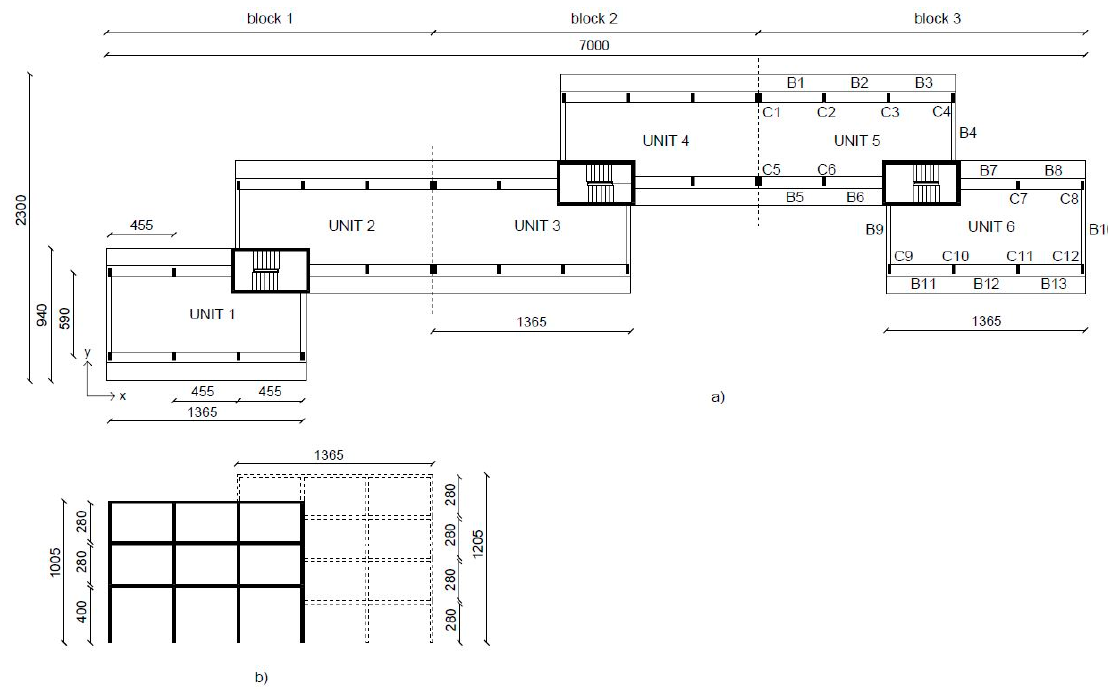
Figure 3. Building A: ( a ) plan of the first floor and ( b ) elevation of block 1.